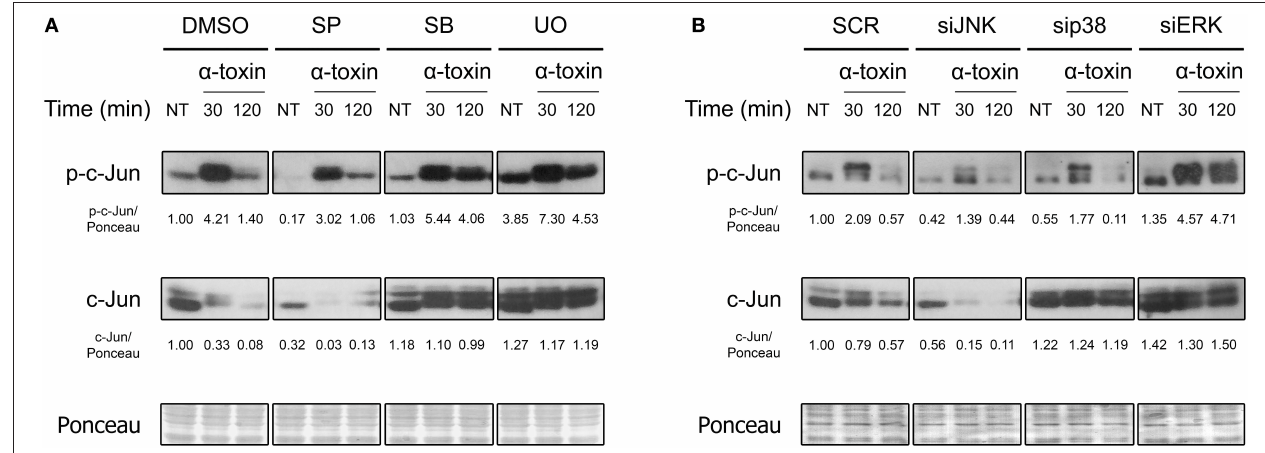
FIGURE 2 | Role of MAPKs in the α -toxin-induced activation of c-Jun. (A) Lung epithelial A549 cells were pretreated with the JNK inhibitor SP600125 (SP) 30 µ M, the p38 inhibitor SB203580 (SB) 10 µ M, or with the MEK1/2-ERK inhibitor U0126 (U0) 10 µ M for 2h, with the carrier DMSO being used to obtain uninhibited controls; (B) MAPKs were silenced using specific siRNAs for JNK (100nM), p38 (25nM), and ERK (25nM). Controls were carried out using SignalSilence ® Control siRNA (SCR). Subsequent to inhibition/silencing, cells were exposed or not to the staphylococcal α -toxin (5 µ g ml-1) for 30 and 120min. Finally, the entire cell extracts were used for Western blotting by using specific antibodies against the phosphorylated and total fractions of c-Jun. Ponceau staining was carried out for loading controls. Pictures correspond to one representative assay of at least three independent experiments. NT, not treated. Below the panels, relative protein levels are shown, with NT values normalized to